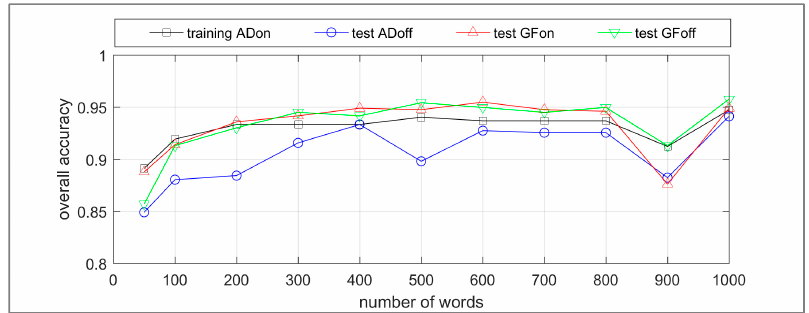
Figure 10. Accuracy of the SVM classifier when trained with images of the ADon dataset and tested on images of the ADoff, GFon and GFoff datasets against vocabulary size.